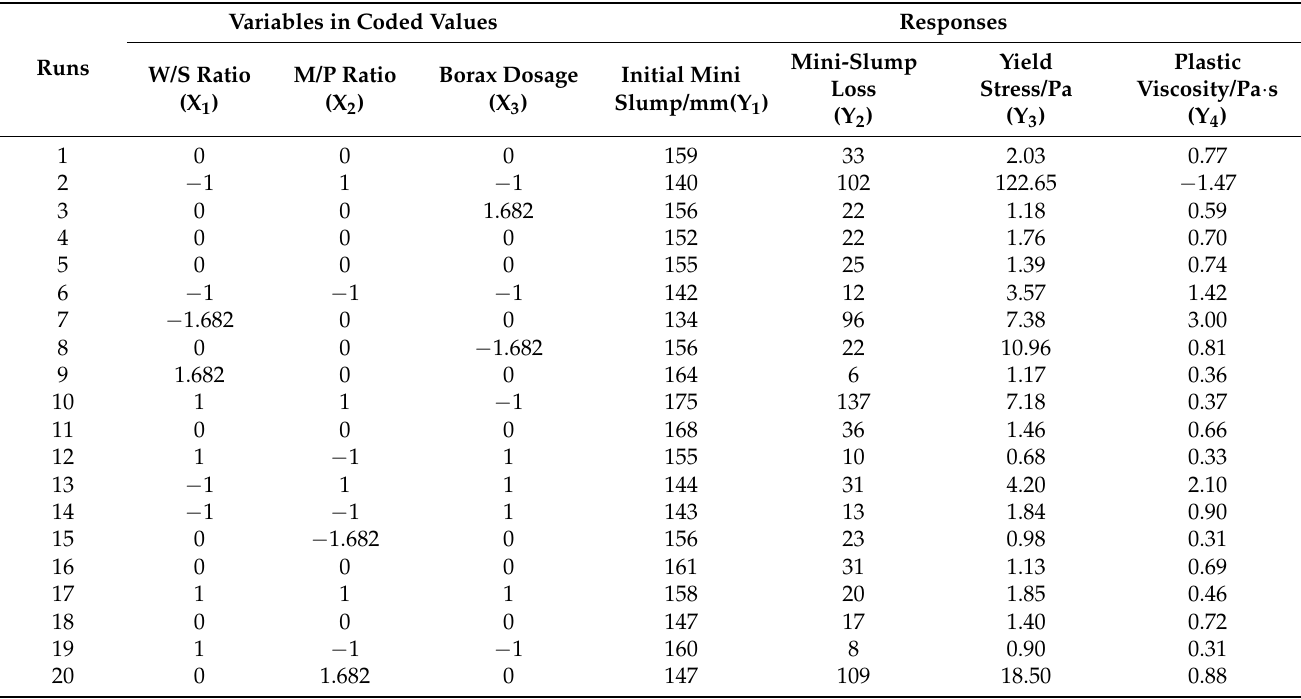
Table 3. The points for 3 factors CCD design (coded value) and corresponding responses.